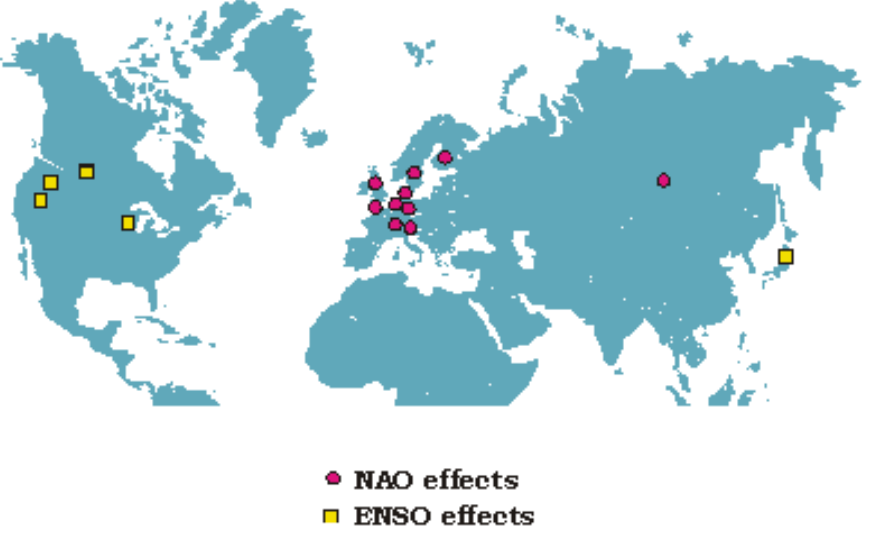
FIGURE 1. Locations of lakes in the Northern Hemisphere that were affected by either the NAO (red symbols) or the ENSO (yellow symbols). See text for references and processes involved.